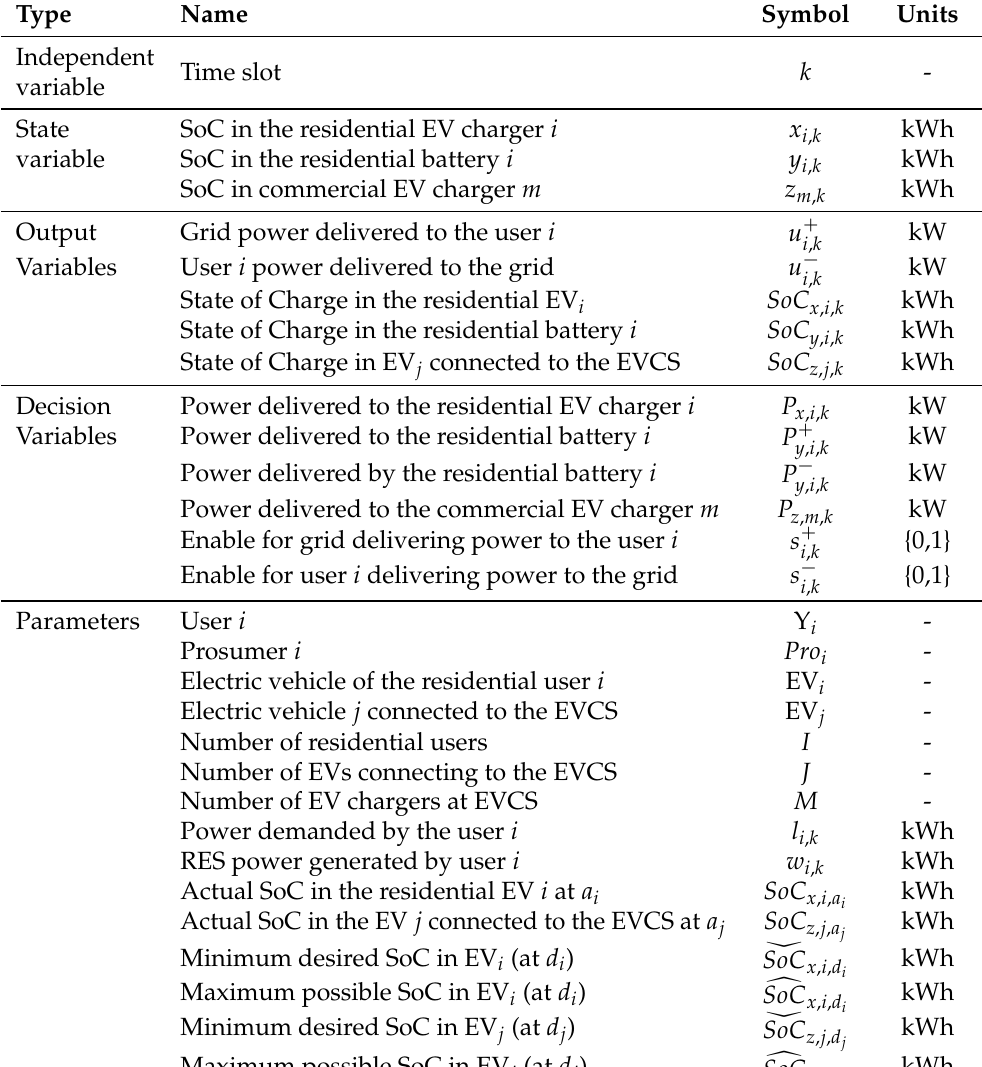
Table 1. Notation of the Electric Vehicle Charging Station